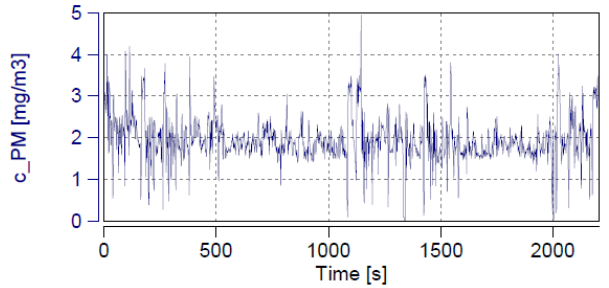
Fig. 7. Particulate matter concentration during the